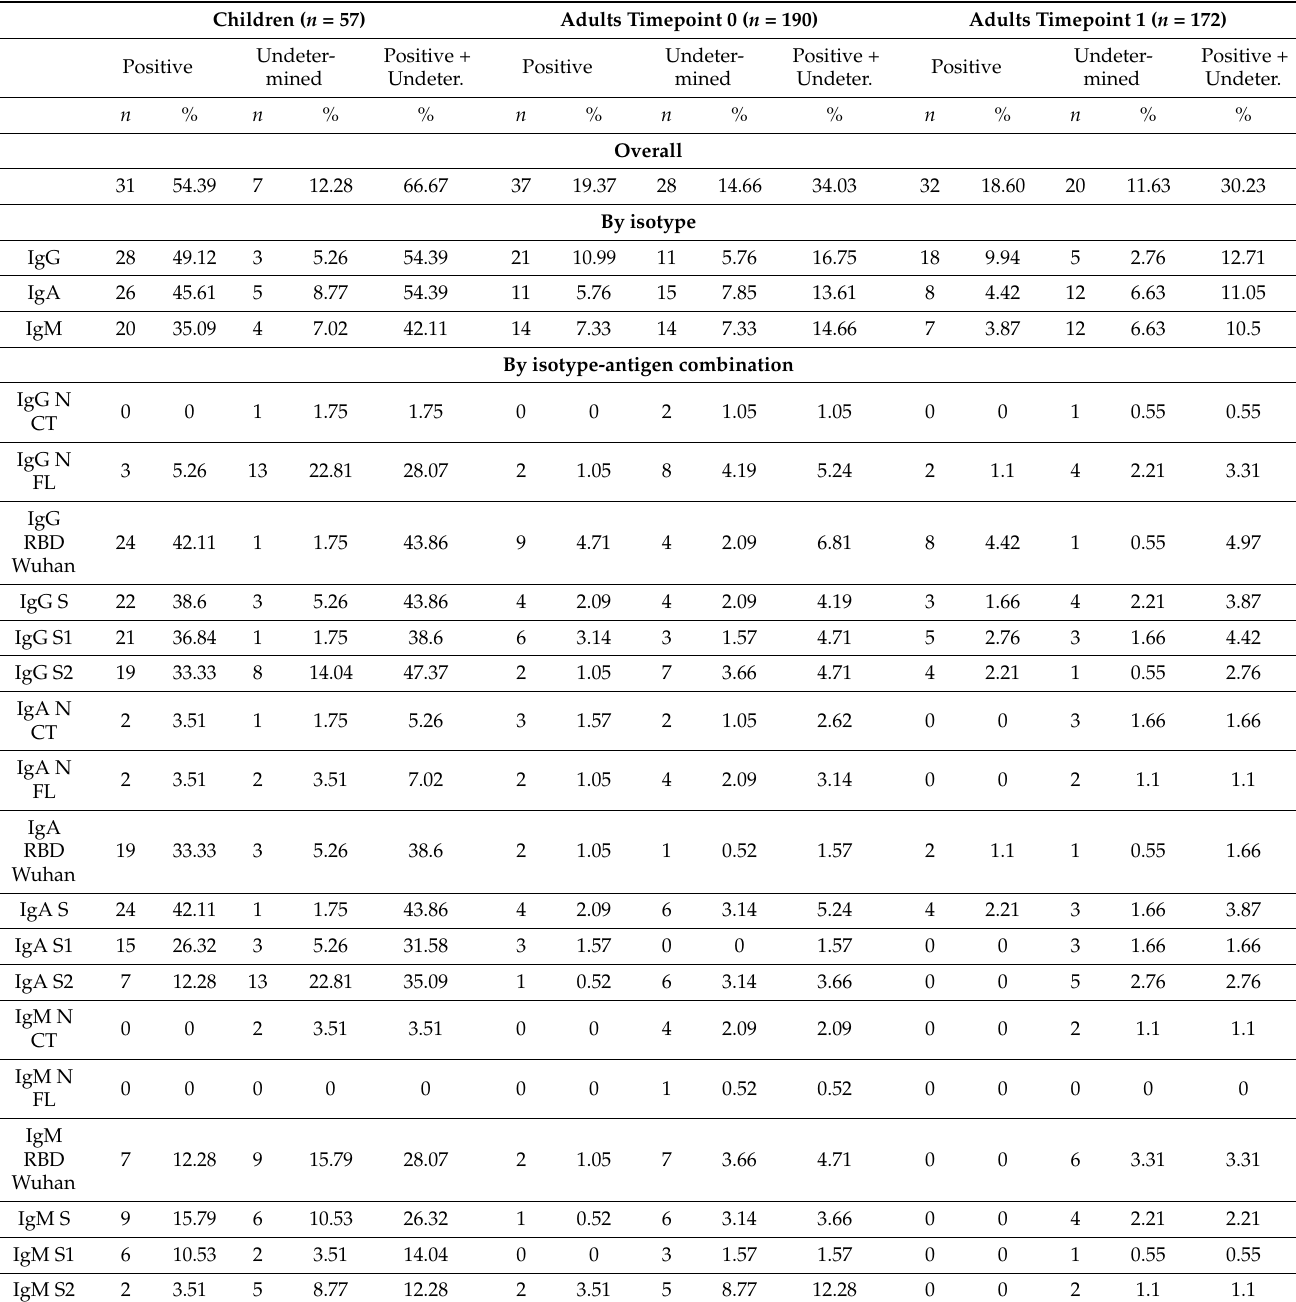
Table 2. Seroprevalence in study participants by isotype and isotype-antigen combination measured by